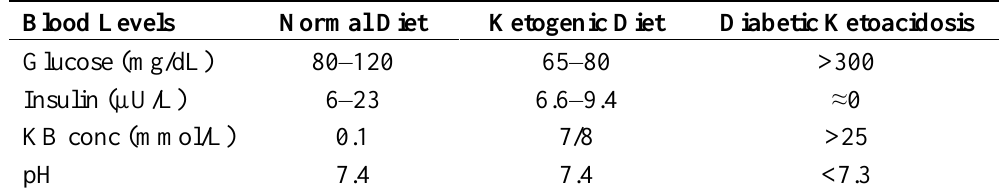
Table 1. Blood levels during a normal diet, ketogenic diet and diabetic ketoacidosis